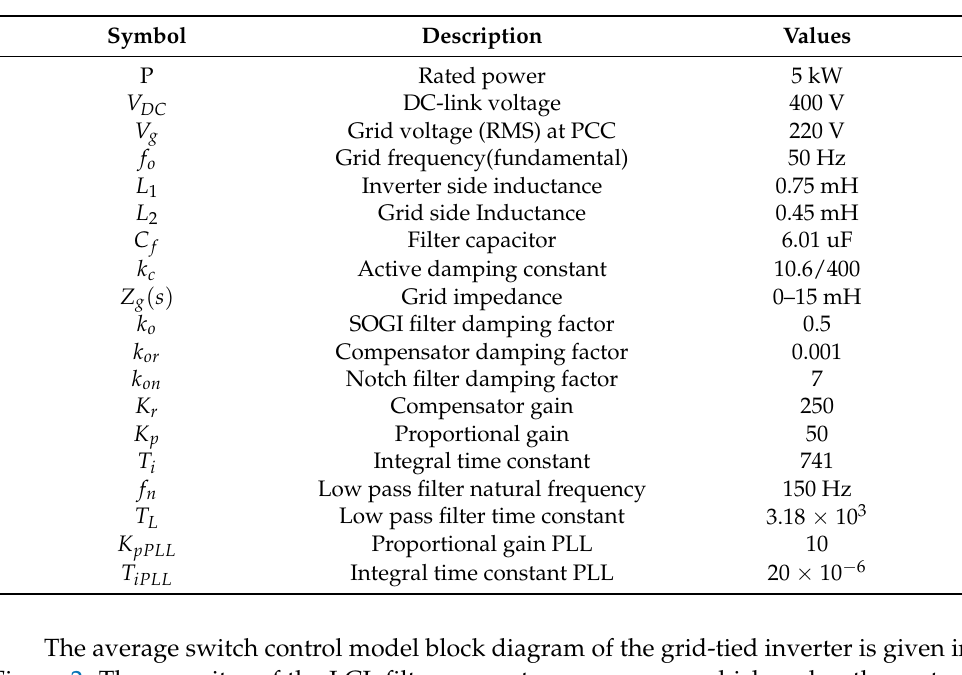
Table 1. The values of system parameters